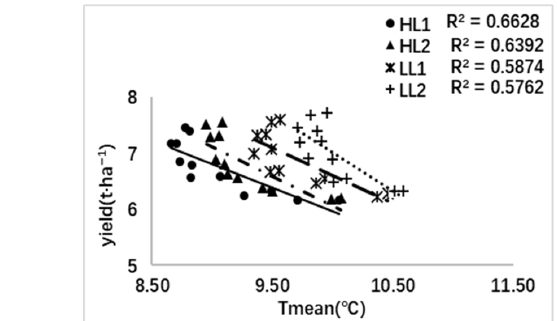
Figure 2. Correlation between radiation and yield during the whole growth period. HL1: 2017–2018